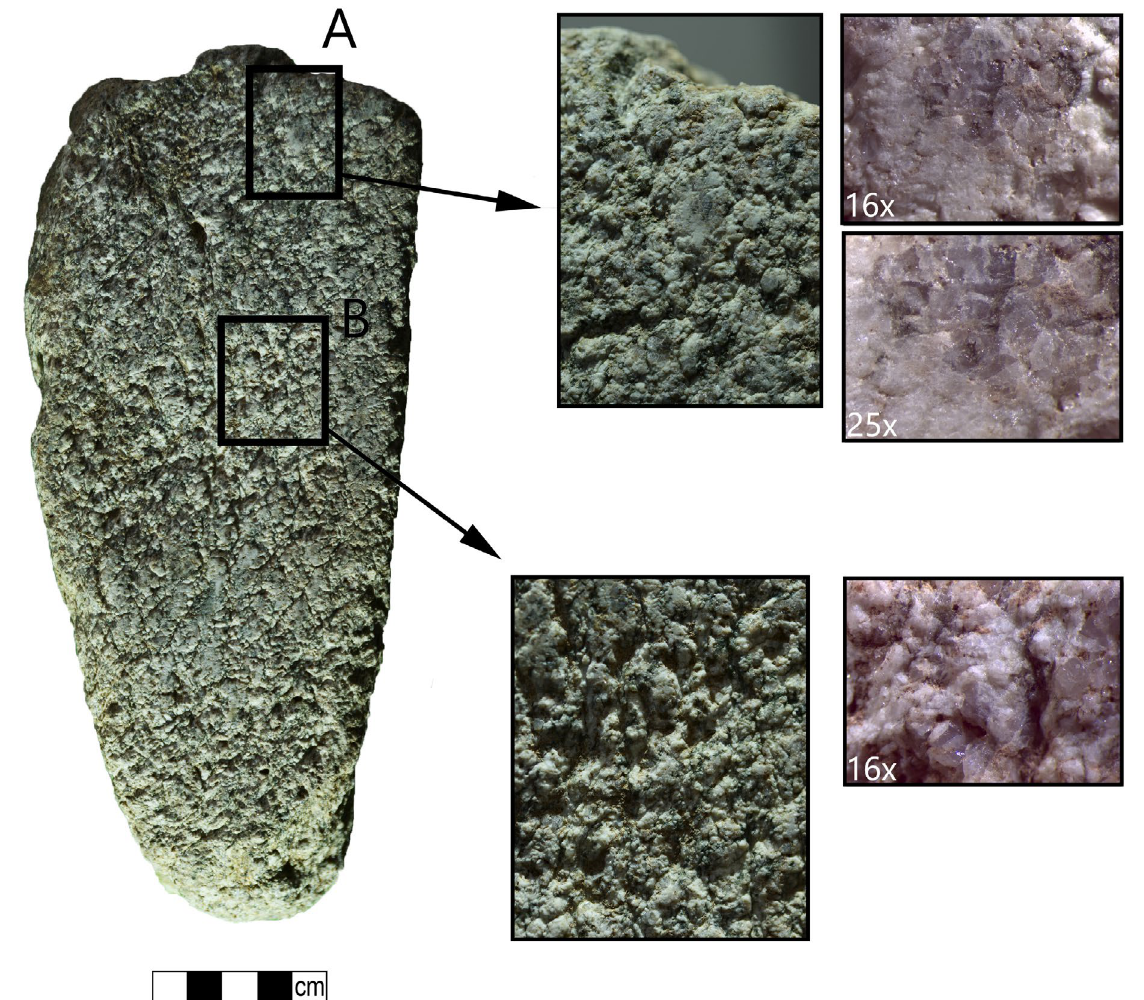
Figure 3. Use-wear analysis with the aid of a stereomicroscope: an example from the archaeological material. Macroscopic and microscopic details from a gneiss handstone from the Neolithic settlement of Stavroupoli exhibiting signs of abrasion as a result from grinding activities (A) but also p ercussive wear (Β), in the form of an irregular concentration of deep cavities, "cutting" into the levelled, smooth and polished plateaus, as a result of the tool's reuse as an anvil (ERC